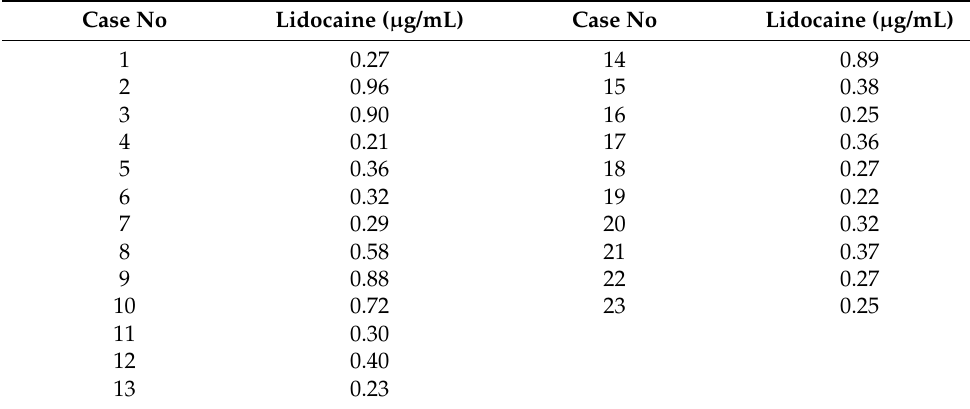
Table 3. Concentration of lidocaine found in the 23 real